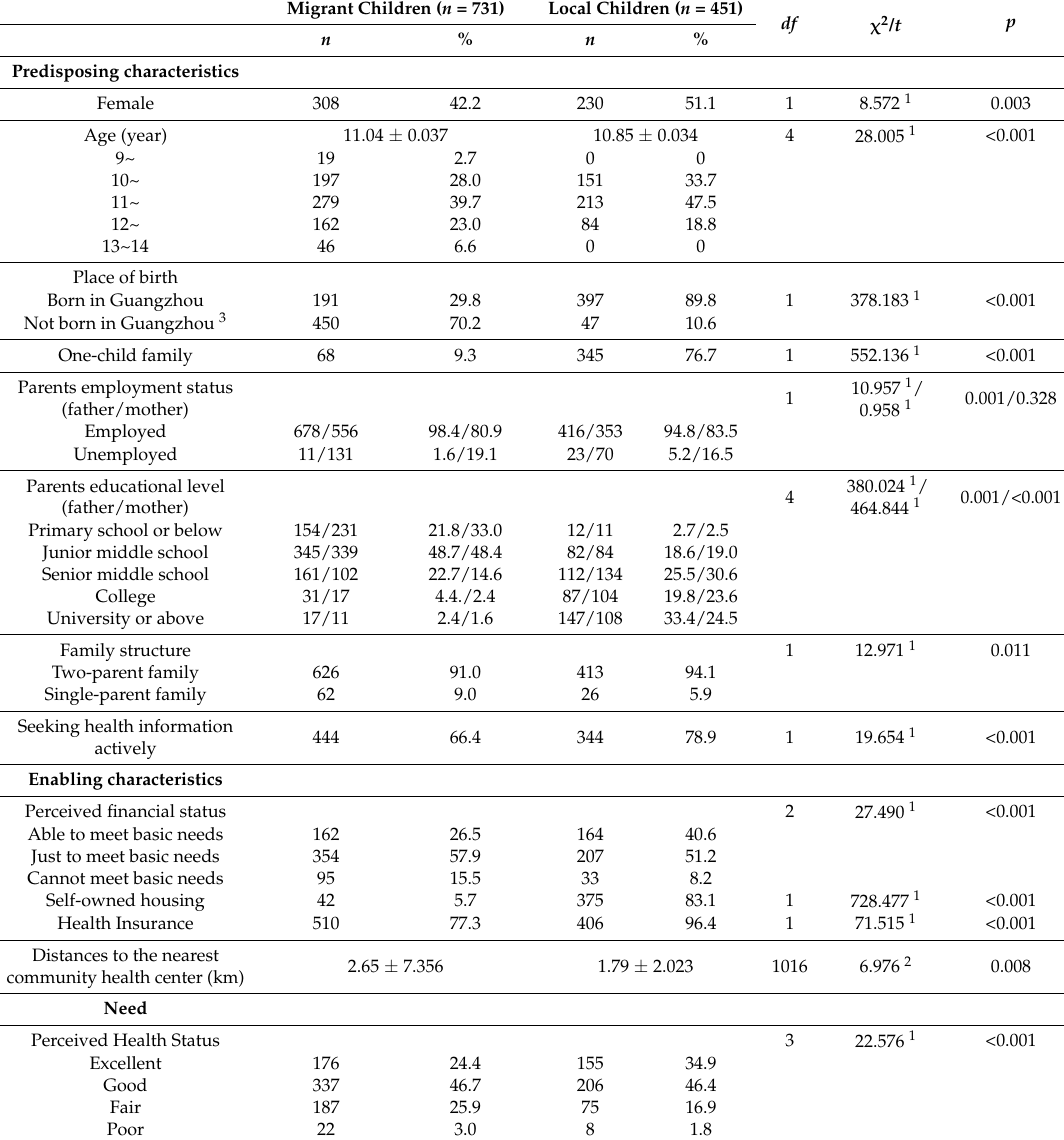
Table 1. Predisposing characteristics, enabling characteristics and need of the participants ( n = 1182). Migrant Children ( n =